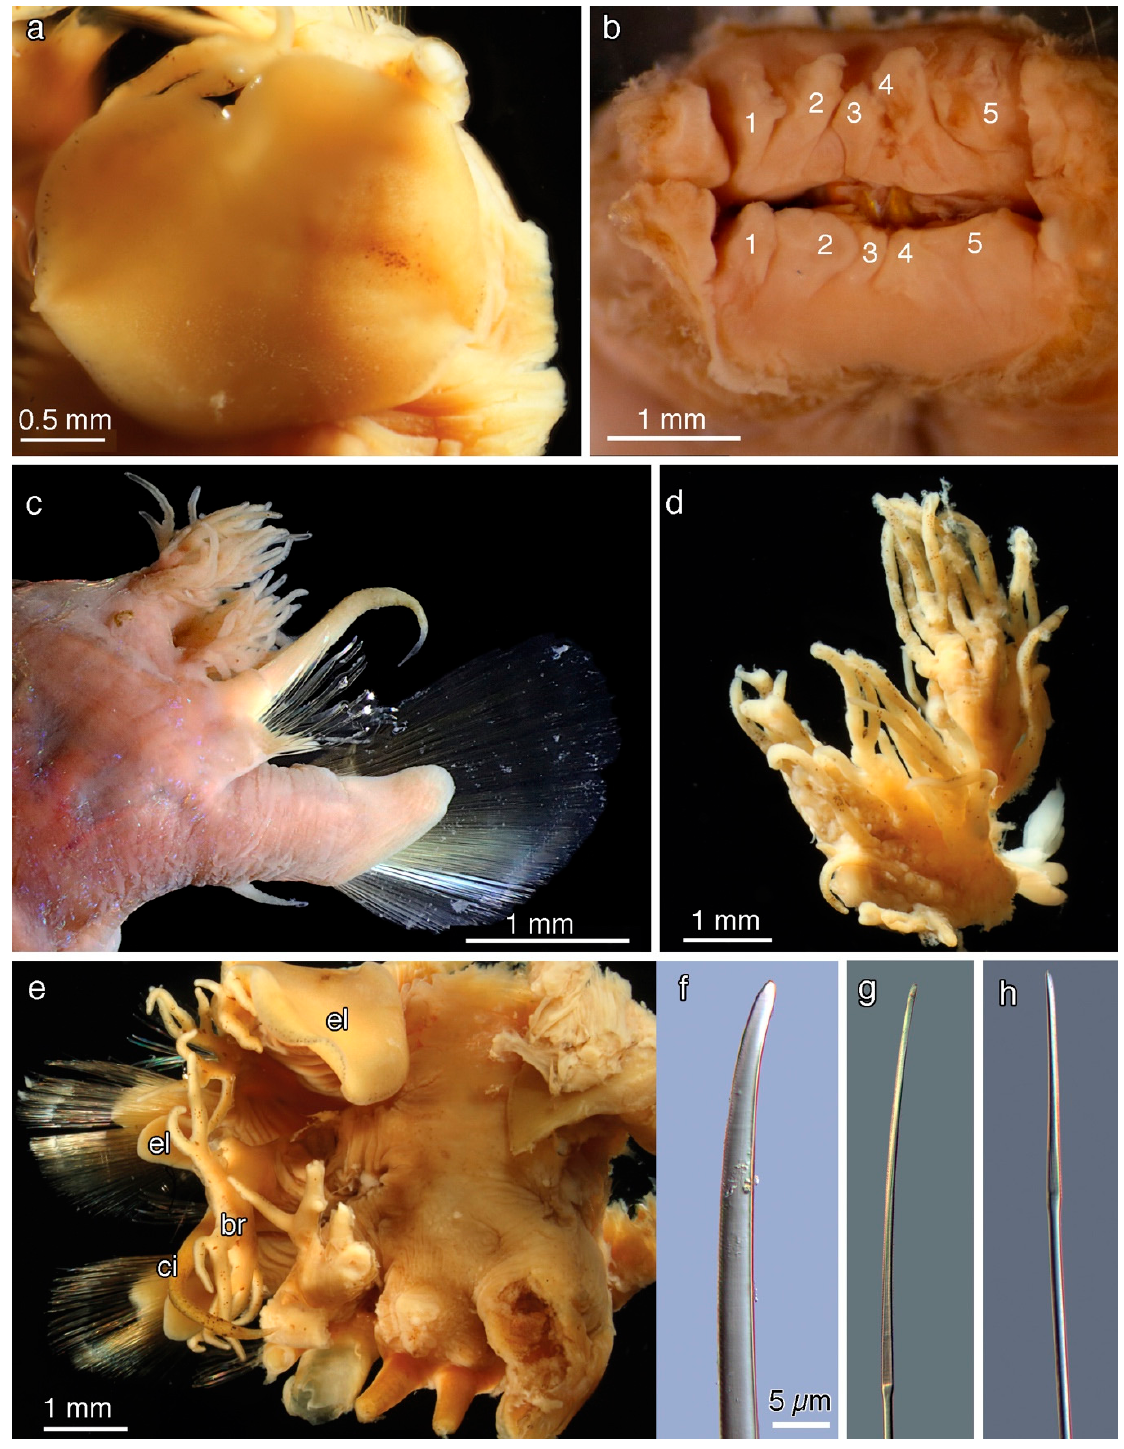
Figure 14. Branchipolynoe kajsae n. sp. female paratypes: ( a ) Elytron from segment 19 (SIO-BIC A6517). ( b ) Frontal view of proboscis showing papillae and jaws (SIO-BIC A6669). ( c ) Parapodium from Segment 14 with dorsal cirrus (SIO-BIC A2160). ( d ) Branchia (dorsal and ventral groups) from Segment 19 (SIO-BIC A6517). ( e ) Posterior part of individual SIO-BIC A2160 (Segments 20 and 21) and pygidium with a pair of anal cirri terminally. ( f ) Notochaeta (Segment 14; SIO-BIC A6662). ( g ) Supraacicular neurochaeta (Segment 14; SIO-BIC A6662). ( h ) Subacicular neurochaeta (segmental 14; SIO-BIC A6662). Same scale for ( f – h ). br, branchia; ci, parapodial cirrus; el, elytron.